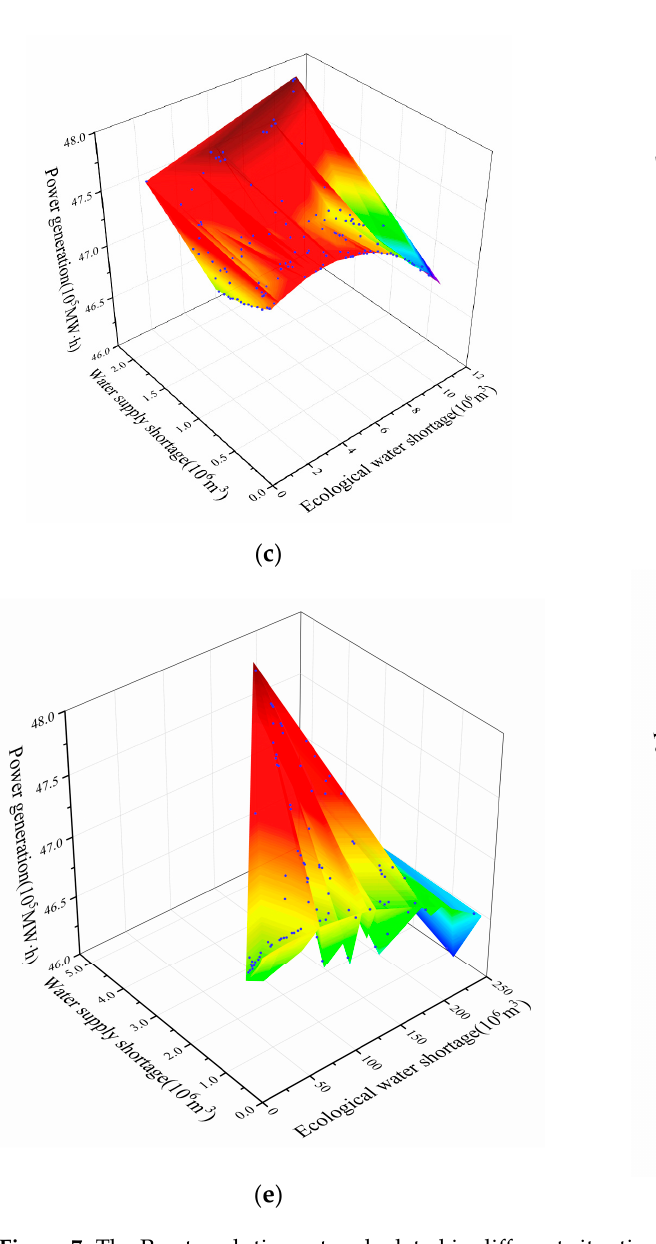
Figure 7. The Pareto solution sets calculated in different situations: ( a ) The multi-timescale nested model (MTNM) was used in a wet year; ( b ) The MTIM was used in a wet year; ( c ) The MTNM was used in a normal year; ( d ) The MTIM was used in a normal year; ( e ) The MTNM was used in a dry year; and ( f ) The MTIM was used in a dry year.